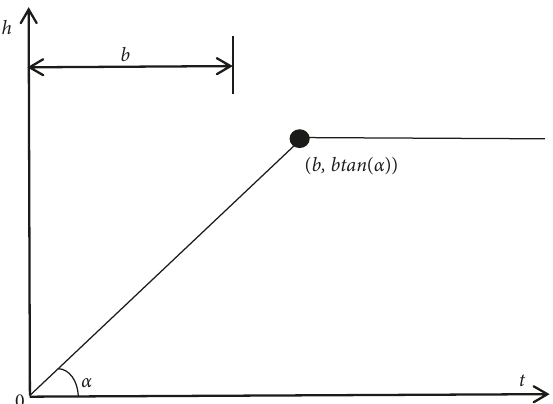
Figure 2: Schematic diagram of cross-section function (linear function).